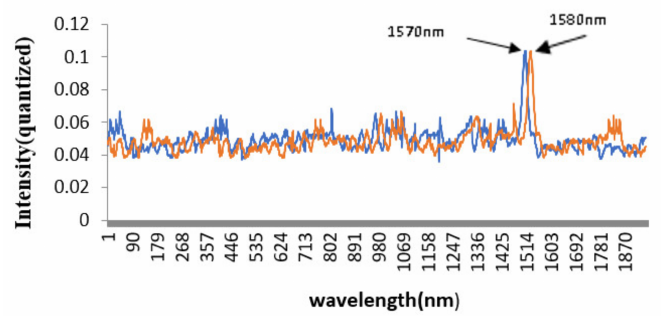
Figure 25. The testing of the resolution of detector 1. Figure 26 is the resolution test result of detector 2. Narrow-band filters with a central wavelength of 2392 nm were selected for testing. The half-width of narrow-band filters with a central wavelength of 2392 nm was 17 nm (2399.2 − 2382.5 = 16.7 nm). Similarly, in general, the resolution of the central region of the spectrum detection range was better than that of the two ends of the spectrum detection range, so the spectrum resolution of detector 2 (1541–2532 nm) was better than that of 17